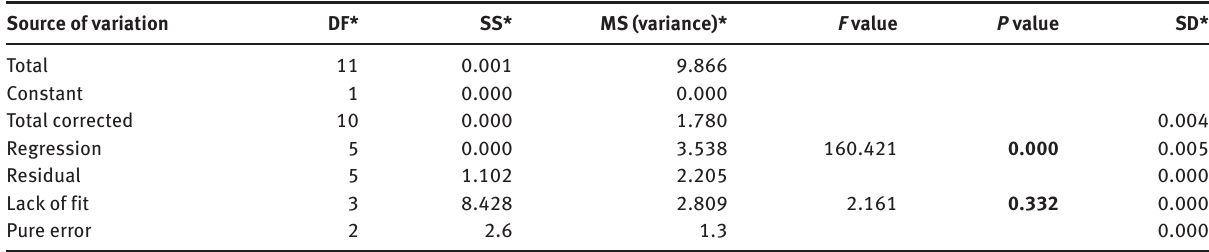
Table 4: Analysis of variance for the fitted quadratic model Source of